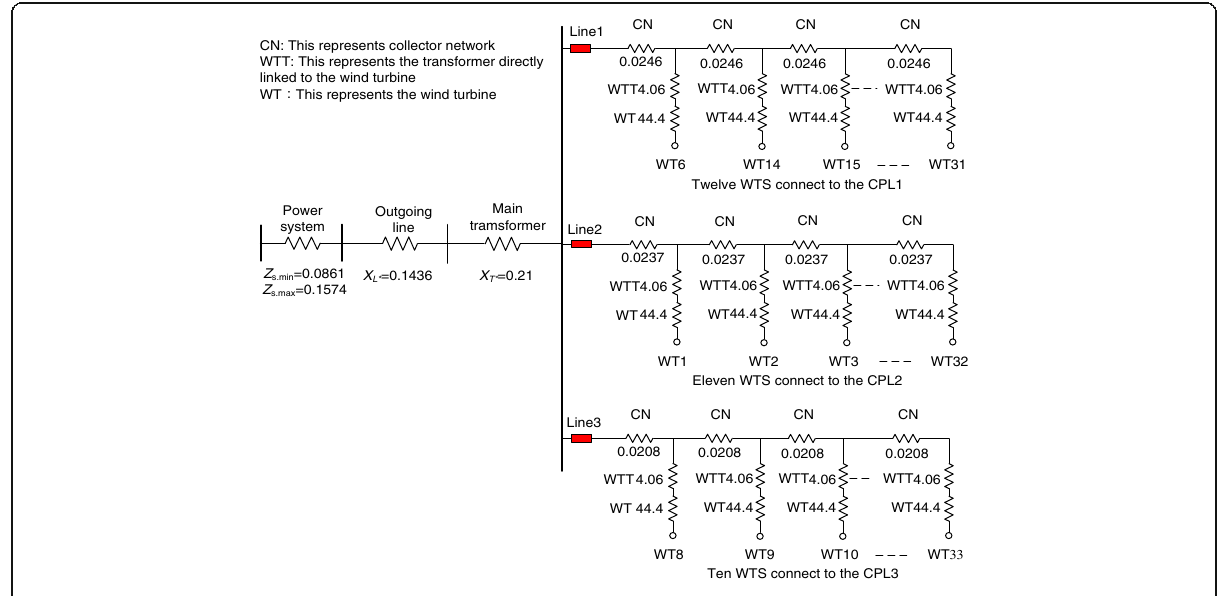
Fig. 5 Equivalent resistance to PSMG wind farm